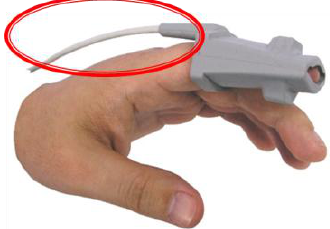
Figure 5. SpO sensor. The sensor’s cable and size make it very uncomfortable to use in 2 sports or social interactions [24].